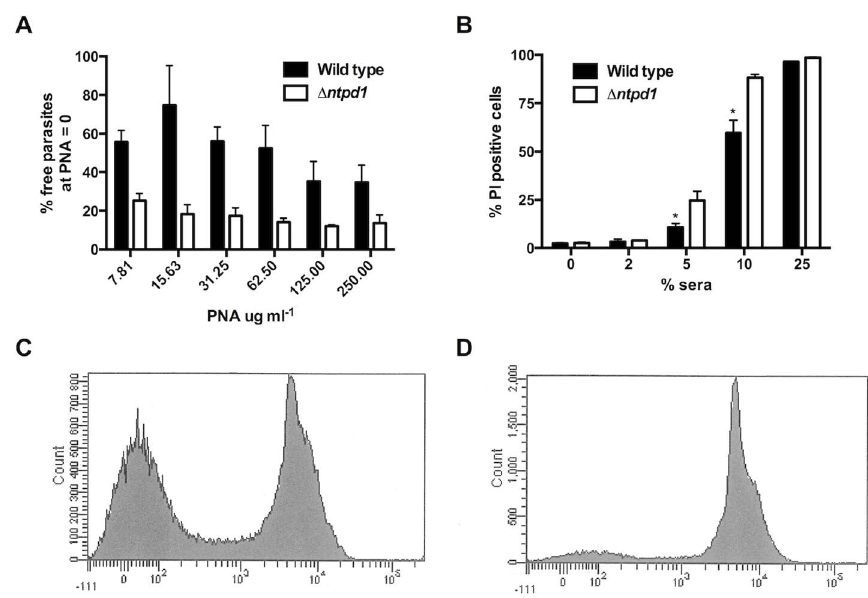
Fig. 5. Truncated LPG synthesis by L.majorNTPD1 null mutants alters parasite biology. A. The number of free-swimming parasites observed following incubation with varying concentrations of PNA, expressed as a percentage of the number of free-swimming parasites observed in the absence of PNA. Compared to wild type L. major (black columns), significantly less unbound L. major D ntpd1 (white columns) were observed at lower concentrations of PNA (* P , 0.05), a trend that continued even at high concentrations of PNA. Data represents a minimum of three biological repeats. B. Percentage of parasites that were PI positive (indicating lysis) following incubation with varying concentrations of human sera. Significantly more L. major D ntpd1 (white columns) were lysed when compared to wild type L. major at sera concentrations of 5 and 10. C and D. Representative flow cytometric analysis of parasites incubated with 10% human sera, demonstrating two populations of cells (lysed and intact) for wild type L. major (C), but only one major fluorescent (lysed) cell population for L. major D ntpd1 (D). Data represents three biological repeats.